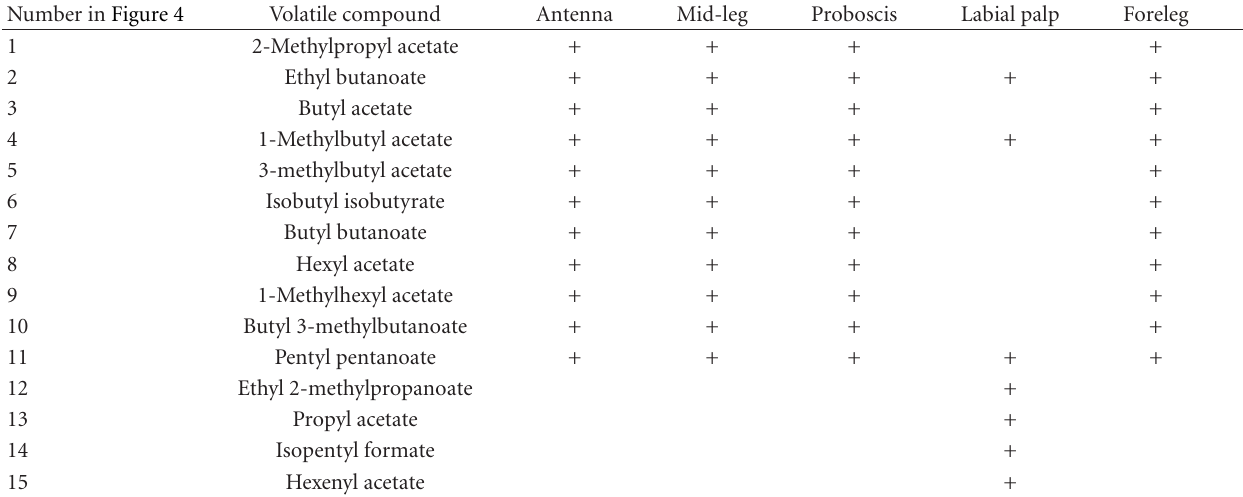
Table 2: Chemical volatile compounds collected from fermented banana and the presence (+) of EAD-responses to these compounds in various appendages of Blue Morpho butterfly ( Morpho helenor